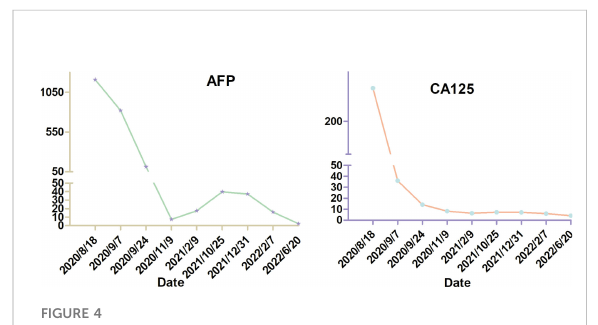
FIGURE 4 The level of alpha fetoprotein (AFP) and cancer antigen 125 (CA125).